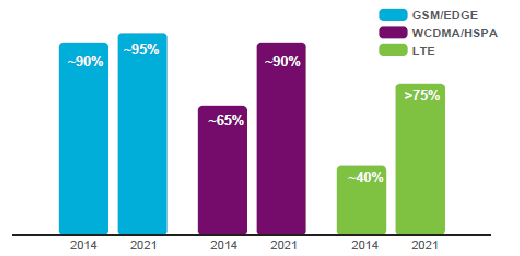
Figure 4: World population coverage by cellular 3GPP